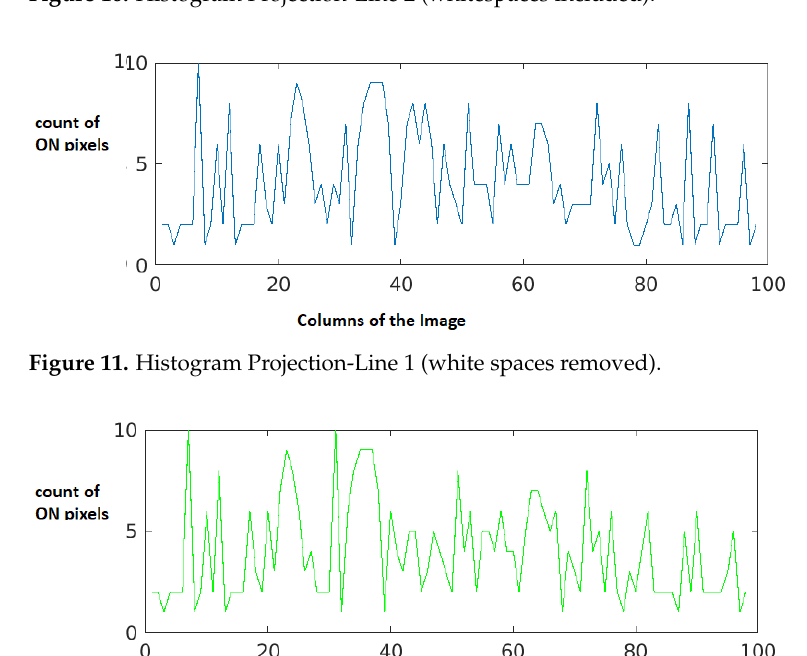
Figure 10. Histogram Projection-Line 2 (whitespaces included).